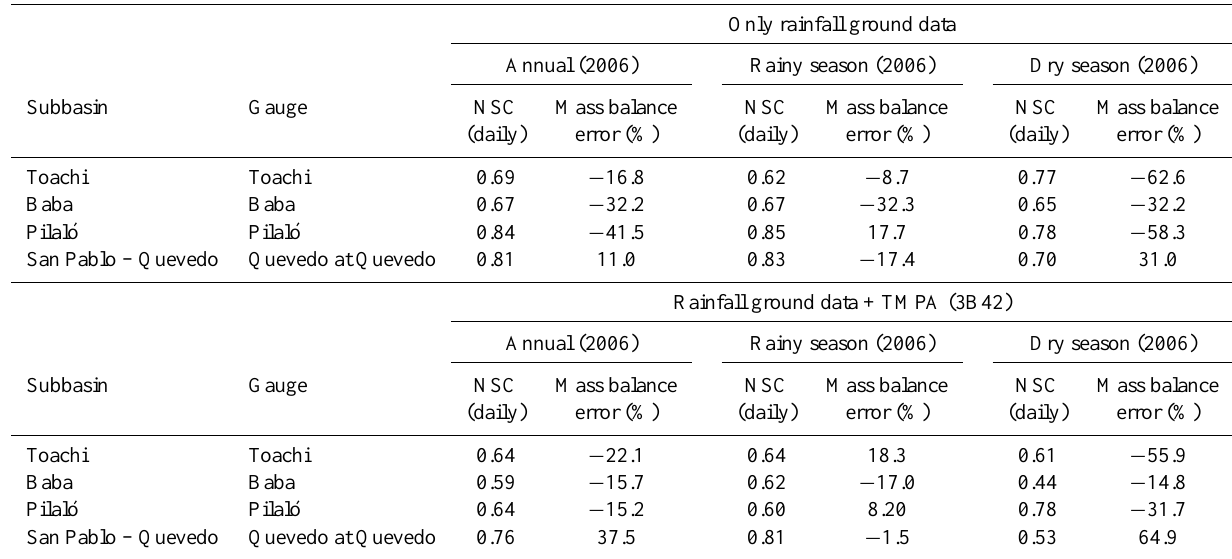
Table A4. NSC and mass balance errors after the Vinces HMS